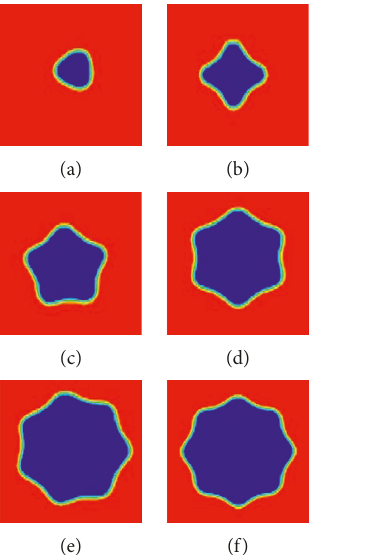
Figure 3: Shape oscillation of a microbubble at different oscillation modes, when f � 130kHz and P d � 42kPa. The corresponding initial radii are 22 μ m, 30 μ m, 36 μ m, 42 μ m, 50 μ m, and 56 μ m. (a) n � 3; (b) n � 4; (c) n � 5; (d) n � 6; (e) n � 7; (f) n � 8. Figure